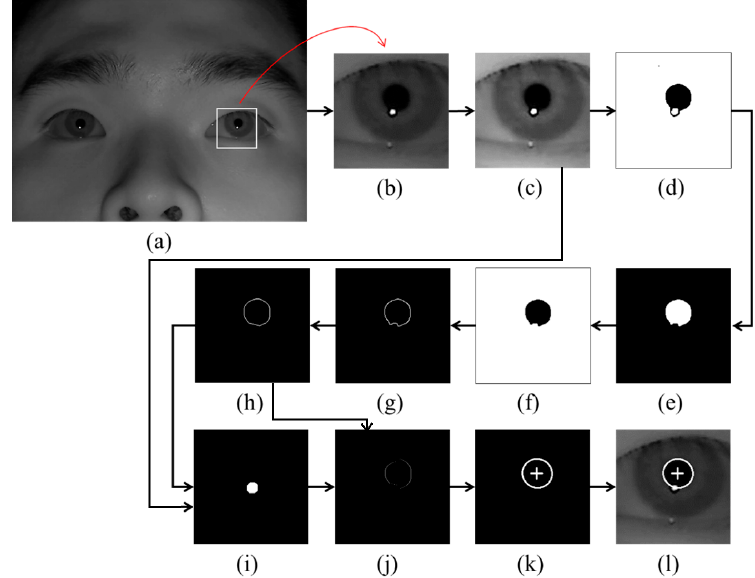
Figure 1. Examples of pupil center and boundary detection: ( a ) rough position of corneal SR is located in the original image ( b ) region for detecting pupil area is defined. Result images by ( c ) histogram stretching, ( d ) image binarization, ( e ) morphological operation, ( f ) component labeling, ( g ) canny edge detection, ( h ) convex hull method, ( i ) image binarization of ( c ), ( j ) subtracting the overlapped parts of ( h ) and ( i ) from ( h ), ( k ) ellipse-fitting method, and ( l ) final detection result of pupil center and boundary.